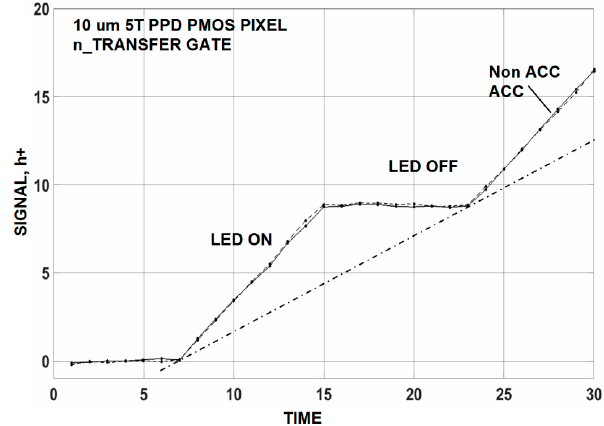
Figure 19. Ultra-low light accumulation (ACC) and non ACC responses without recombination loss.